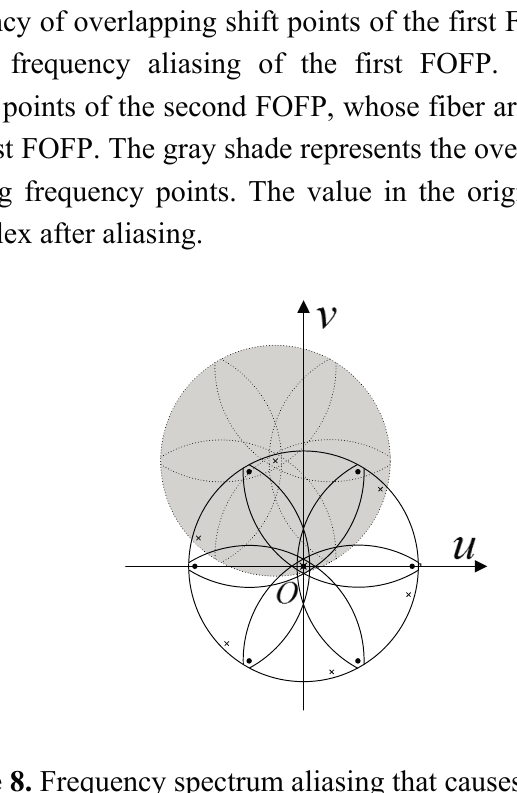
Figure 8. Frequency spectrum aliasing that causes centroid